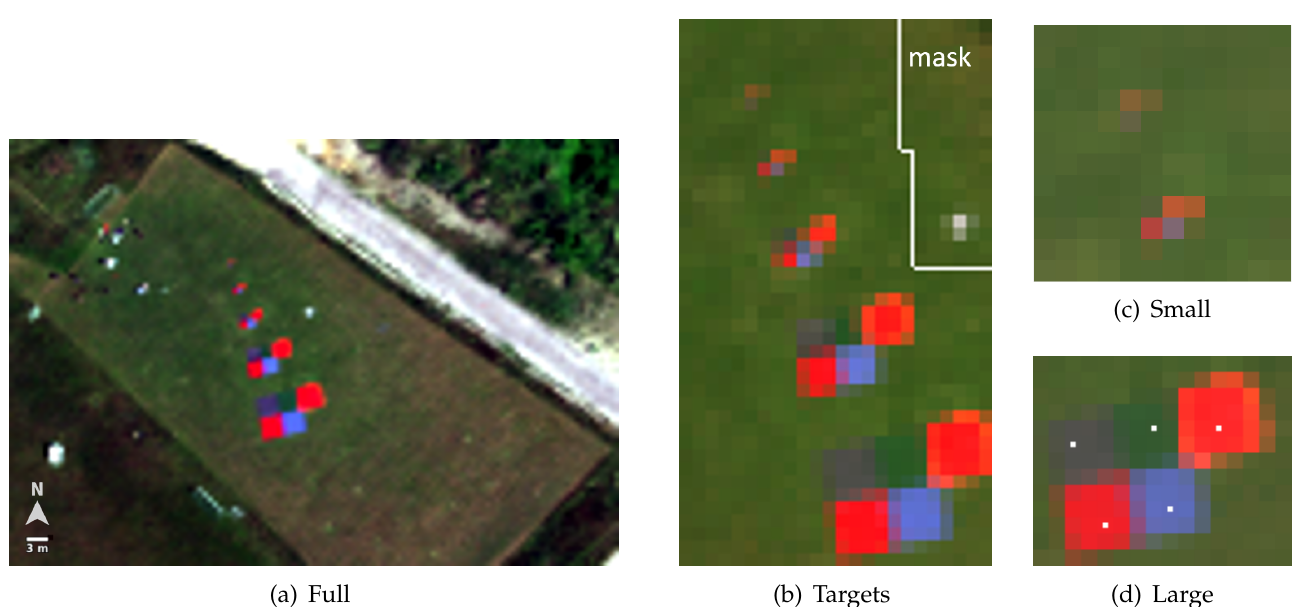
Figure 4. True color composites of the HySpex subsets provided in the DLR HySU benchmark dataset. The whole area of interest within a larger context is depicted in ( a ). All targets at different sizes and mixture levels are contained in subset ( b ). Here, the bright target in the upper part of the image to the right indicates the location of the white panel used as reference for the in-situ data collection. All area northeastern from the overlaid white line, also including mixtures of grass and road in the northeastern corner, can be masked out and excluded from endmember extraction assessments. A small subset with a high degree of mixture containing the small 0.25 and 0.5m targets only is reported in ( c ). The case of the large 3m targets only is represented in ( d ). Here, the locations of image elements collected for the spectral library reported in Figure 5 are marked in white. A full description of each subset in given in Section 2.2.2.